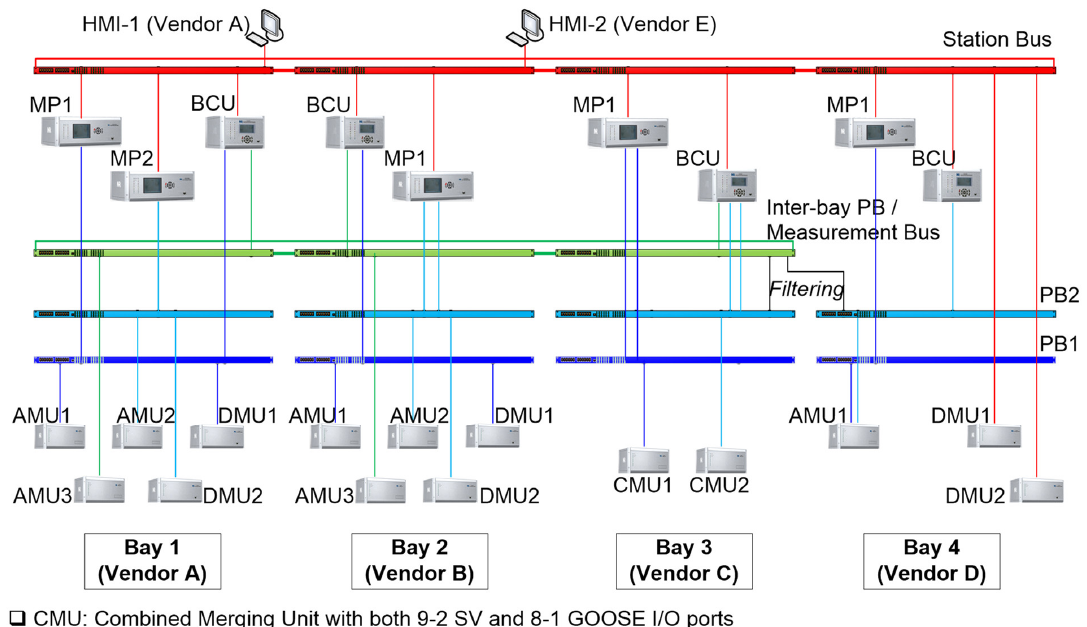
Figure 4. Device arrangement in the proposed substation PAC system architecture, i.e., one station bus, one inter- bay/measurement process bus, and two process buses.